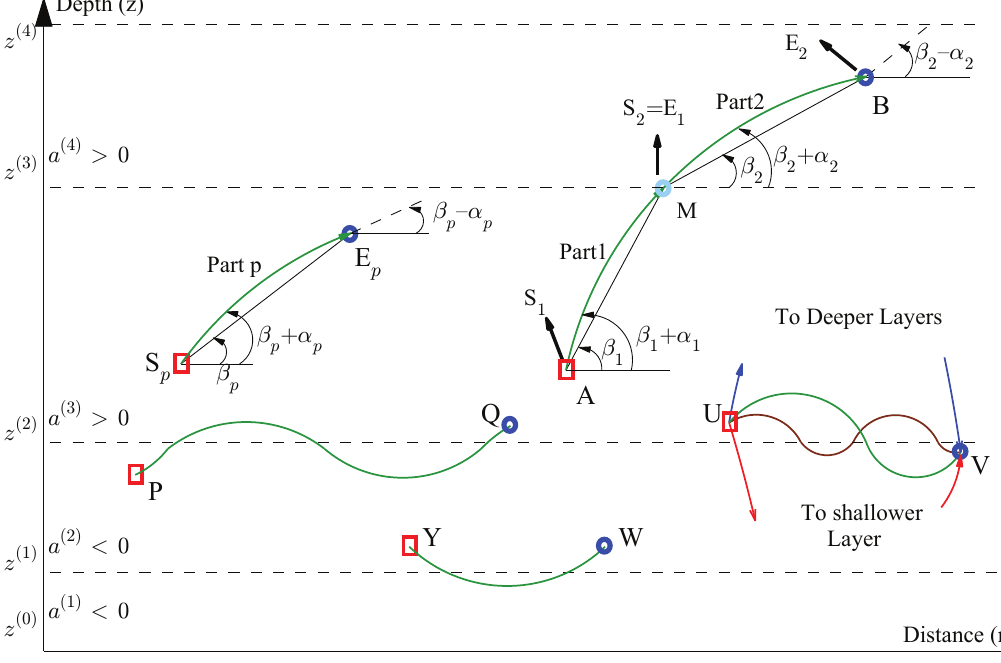
Figure 2. Samples of ray trajectories as they travel through different